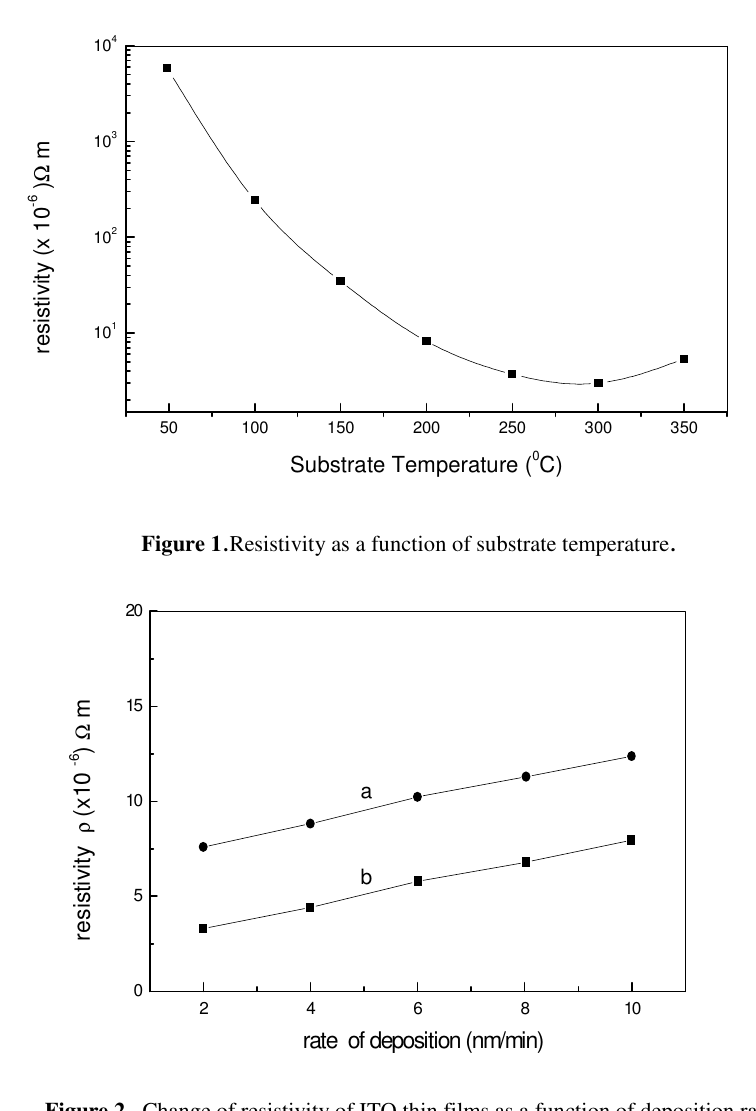
Figure 2 . Change of resistivity of ITO thin films as a function of deposition